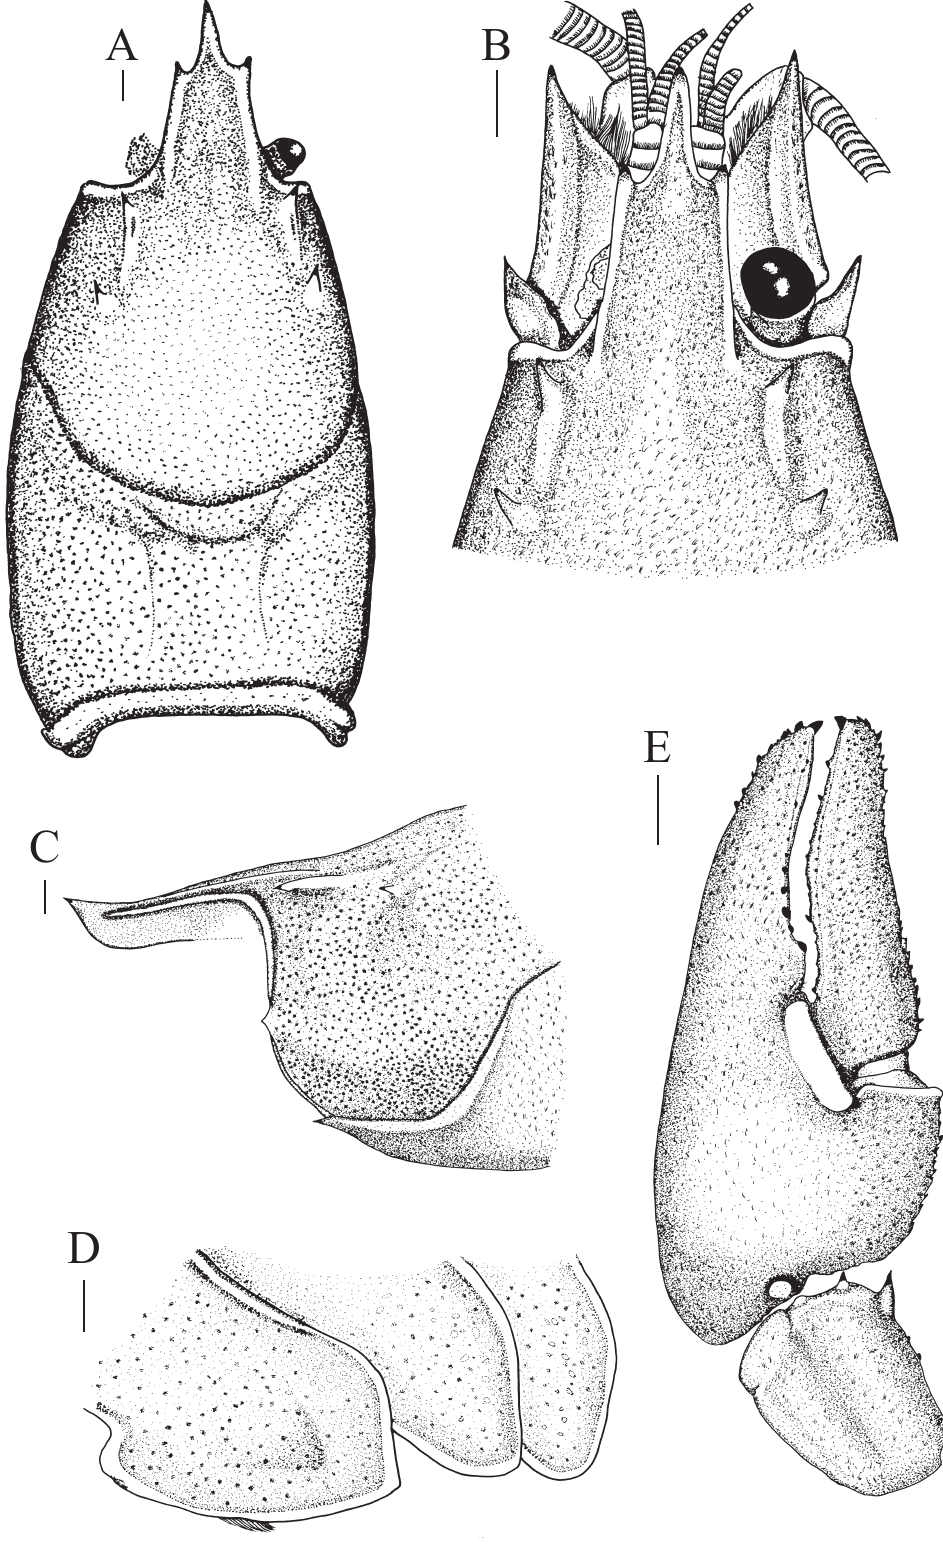
Figure 1. Pacifastacus leniusculus leniusculus (Dana, 1852): all figures from syntypic male (USNM 44408). A, Dorsal view of carapace; B, dorsal view of rostrum; C, cephalolateral view of carapace; D, lateral view of second to fourth pleonal somites; E, dorsal view of left cheliped. Scale bars = 2